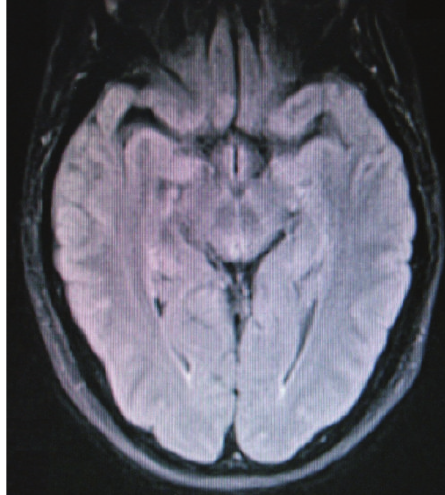
Figure 4: Fluid attenuated inversion recovery magnetic resonance imaging at follow up (15 days after the event) indicating that all lesions have